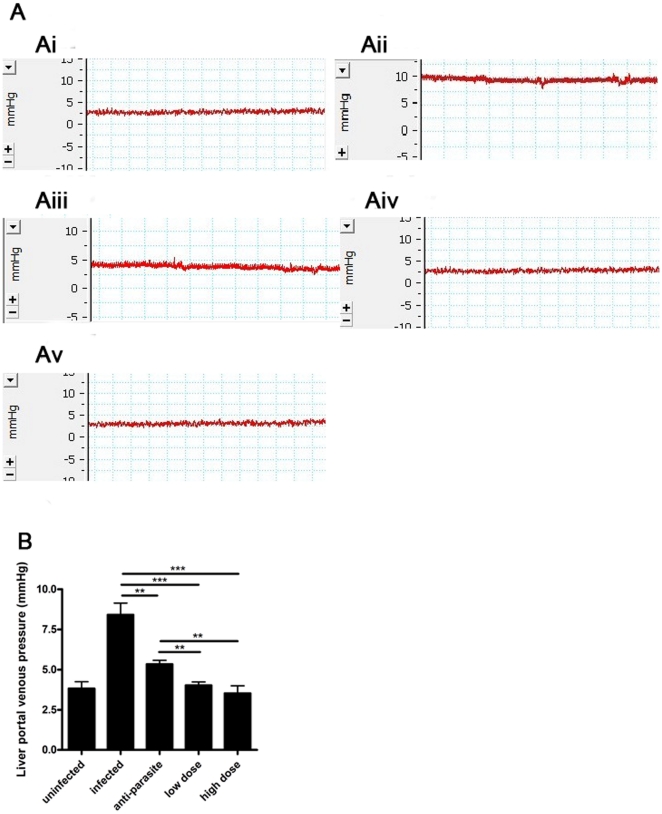
Anti-fibrosis treatment with prizaquantel reduced hepatic portal venous pressure.Hepatic portal venous pressure was measured by PowerLab8SP and analyzed by chart5 software. (A) Representative recording images were showed: Ai, uninfected; Aii, infected; Aiii anti-parasite; Aiv, low dose; Av, high dose. (B) Statistical analysis of each group hepatic portal venous pressure. Although anti-parasite treatment reduced portal venous pressure compared with infected group, anti-fibrosis treatment (both low dose and high dose group) further reduced the pressure to nearly uninfected level. (** p<0.01, *** p<0.001).